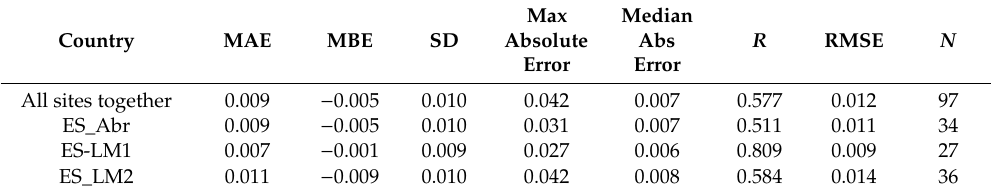
Figure 7. Examples of Mo maps derived from the “simplified triangle” using the Sentinel-3 data. The Mo maps refer to the following acquisition dates: ( a ) 16 May, ( b ) 23 June, ( c ) 25 July, ( d ) 5 August, ( e ) 25 August, and ( f ) 25 September. Table 5. Summarized results of the SSM comparisons. All statistical parameters apart from correlation coefficient ( R ) and sample size ( N ) are expressed in cm 3 cm -3 .